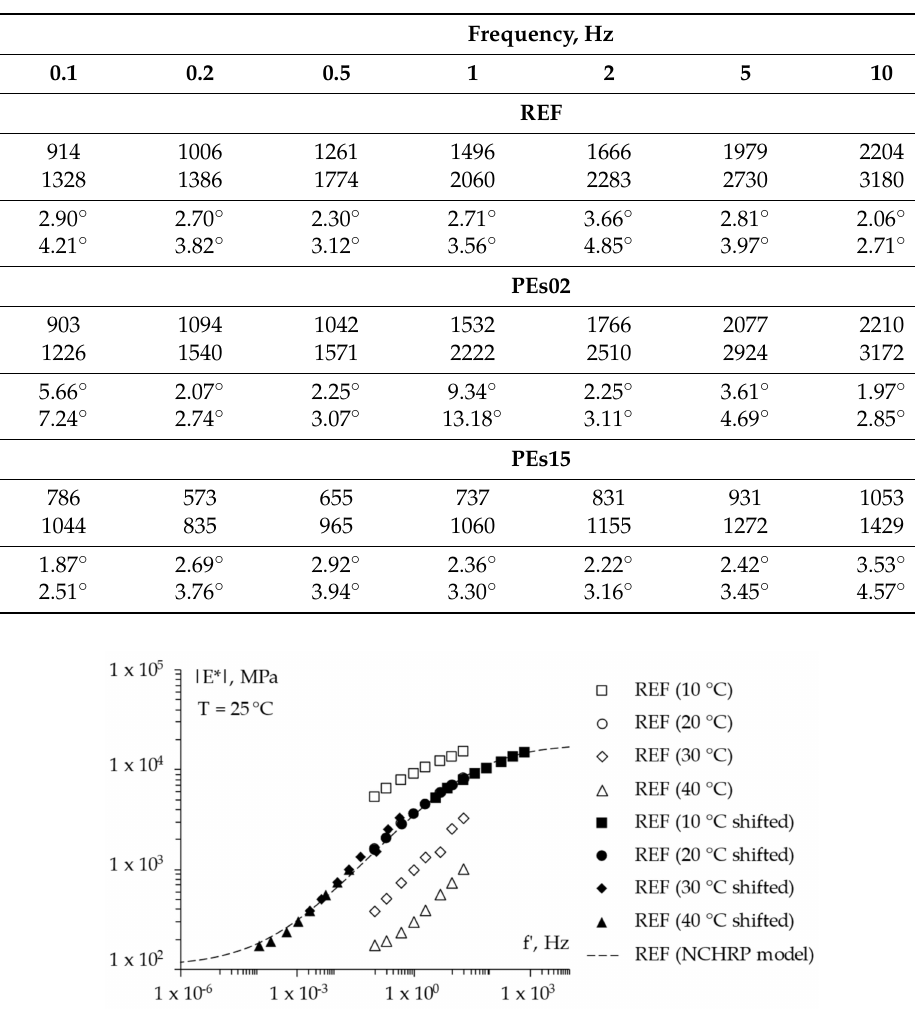
Table 6. The 4PB test repeatability: single-operator precision for the stiffness modulus and phase angle.